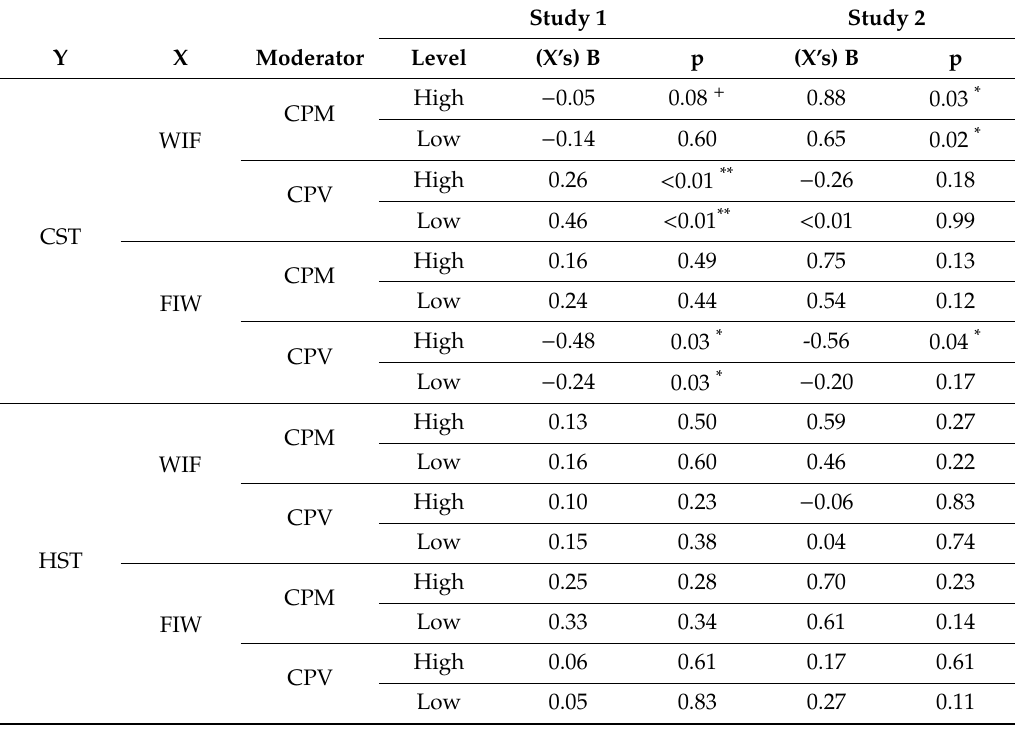
Table 6. Simple slope